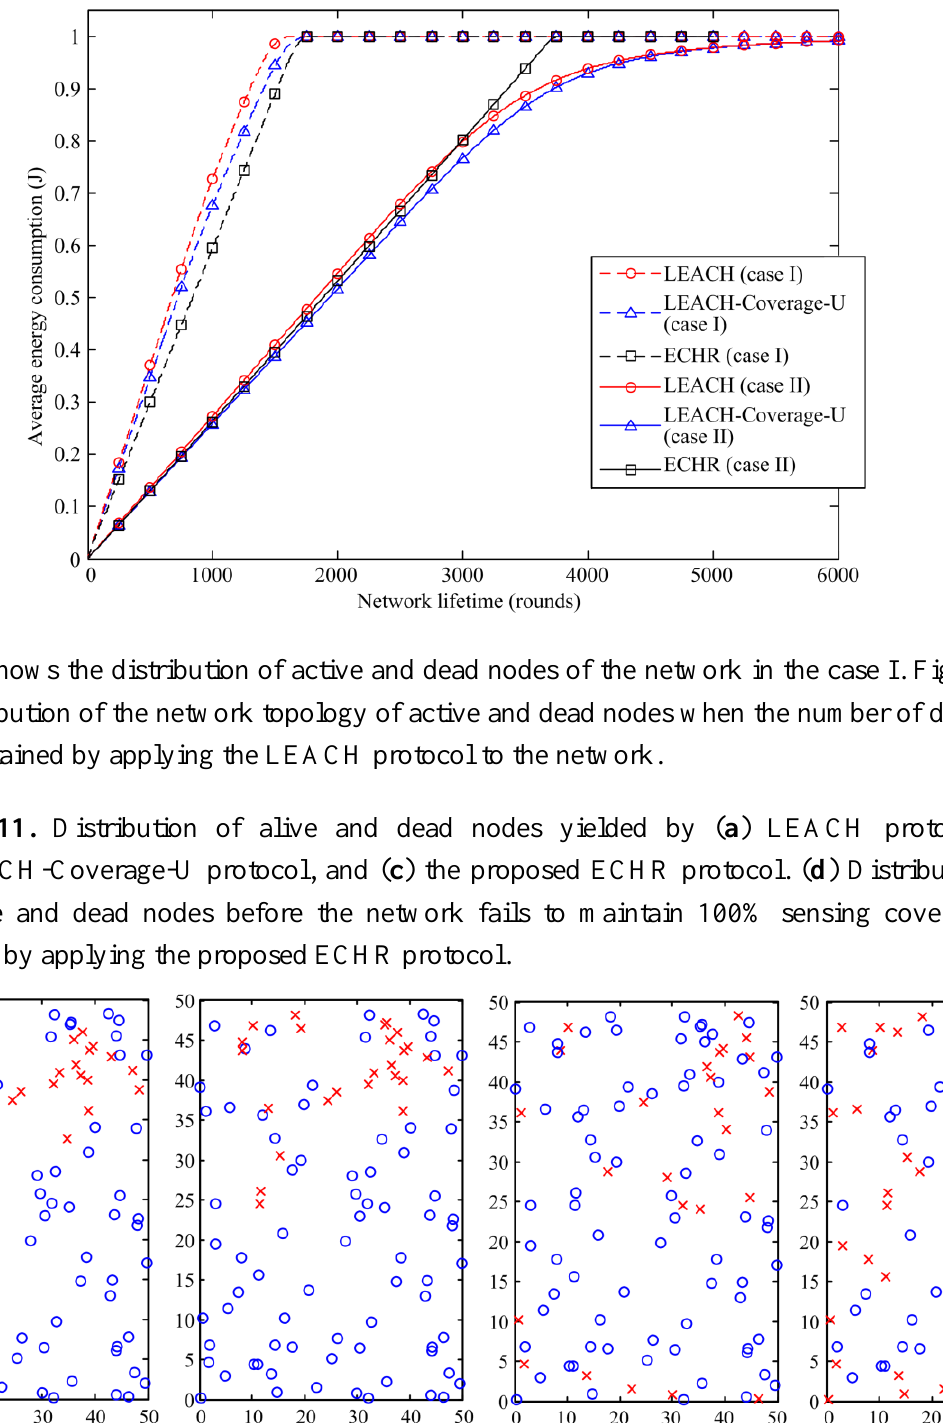
Figure 10. Comparison of the average energy consumption of the proposed ECHR protocol with those of other protocols.